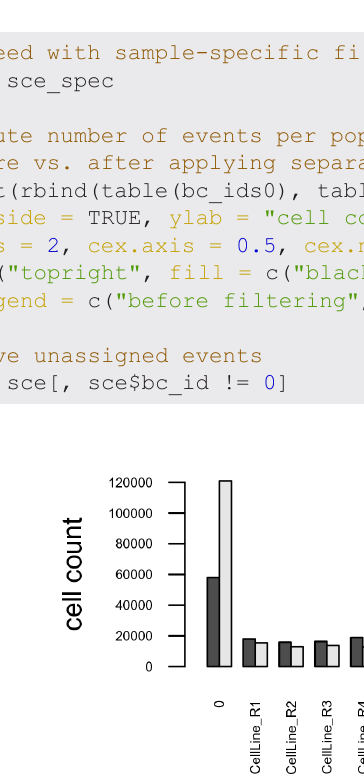
Figure 8. Barplot of cell counts before (black) and after (grey) applying separation